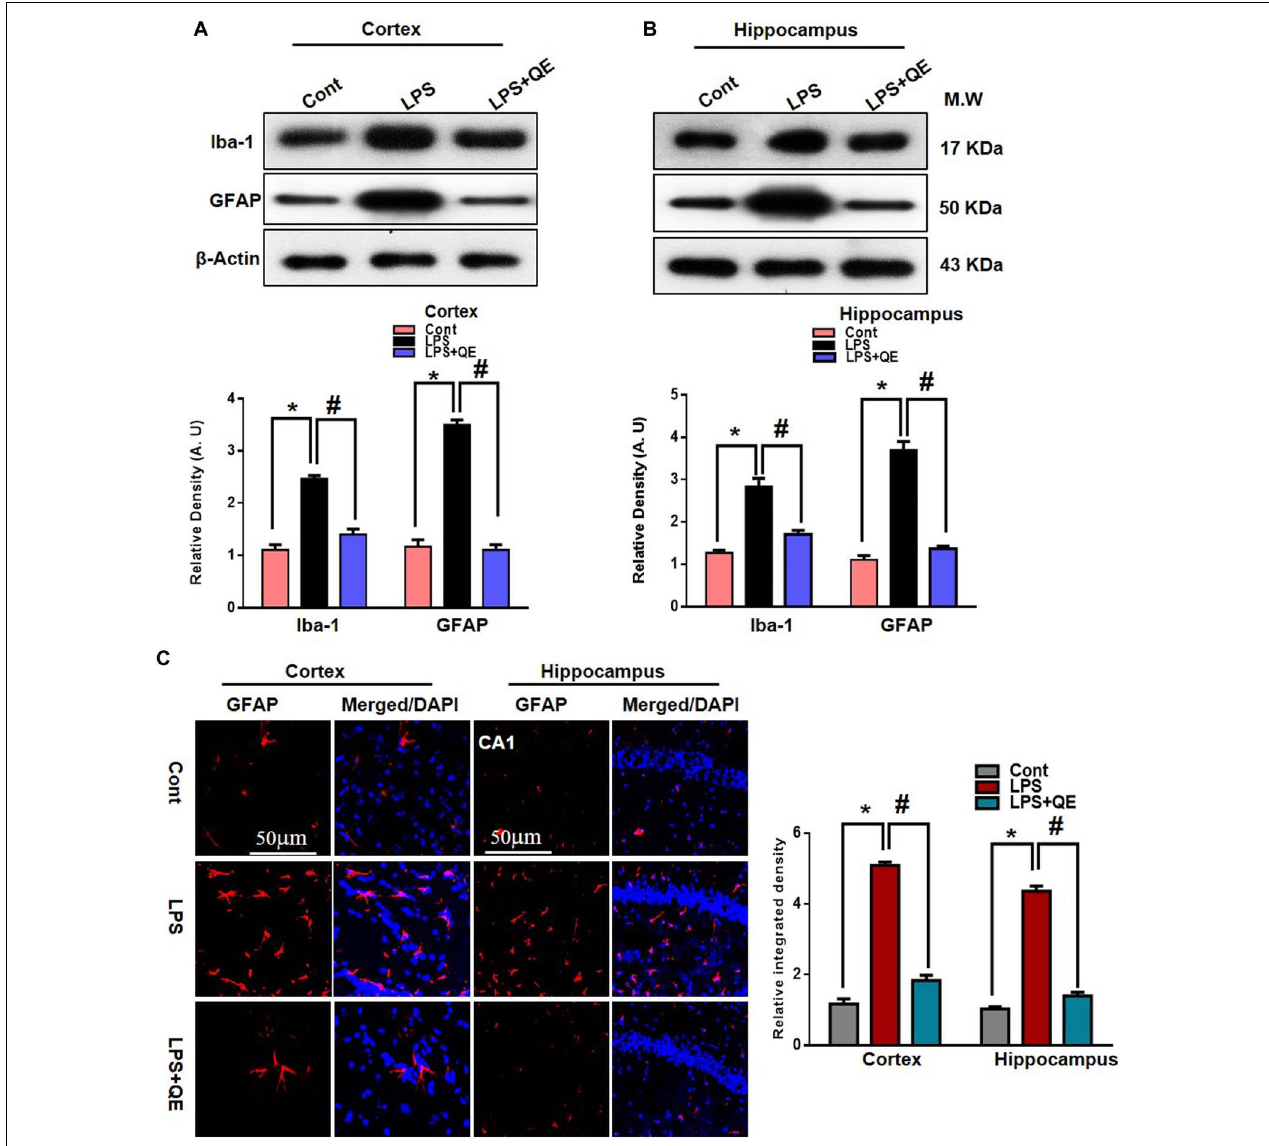
FIGURE 4 | Quercetin ameliorated LPS-induced activated gliosis in the cortex and hippocampus of adult mice. (A,B) Western blotting of the proteins GFAP and Iba-1; their differences in the cortex and hippocampus of mouse brains are represented by a histogram. β -Actin was used as a loading control. The quantified density values are shown in arbitrary units (A.U.) as the means ± SEM for the respective shown protein (8 mice/group). (C) Representative immunofluorescence images and the quantified histogram of activated GFAP in the cortex and hippocampus of adult mice (5 mice/group). Magnified 10 × . Scale bar = 50 µ m. The expressed data are relative to the control. ∗ Significantly different from the control; # significantly different from LPS-treated group. Significance: P <